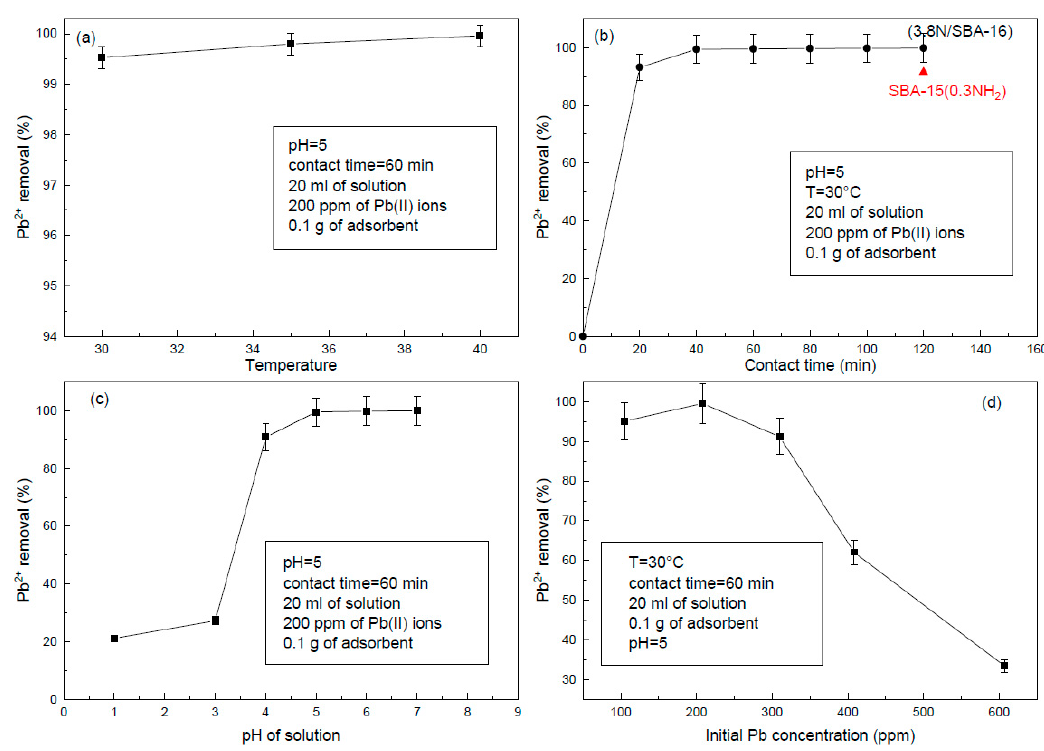
Figure 9. Influence of ( a ) temperature, ( b ) contact time, ( c ) pH, and ( d ) initial lead concentration on the Pb 2 + removal from aqueous solution by the adsorption onto 3.8N / SBA-16. The SBA-15-based